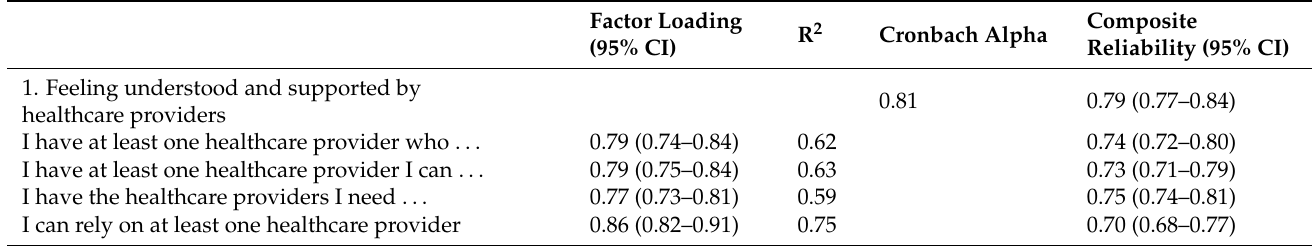
Table 3. Psychometric properties of the Portuguese translation of the Health Literacy Questionnaire among people with diabetes in